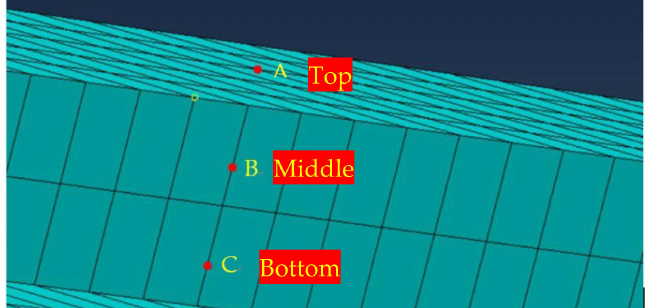
Figure 13. Three points A, B, and C at different depths in the cladding